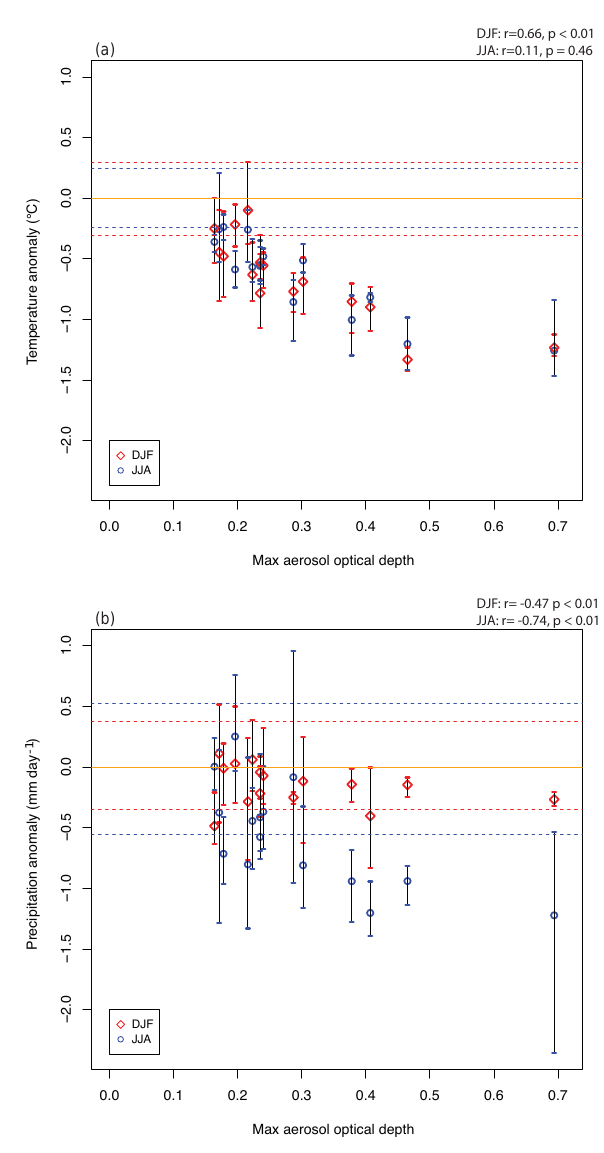
Figure 9. (a) Average temperature anomaly during DJF within the SAMS region (red; 20 to 0 ◦ S, 77.5 to 45 ◦ W) and equatorial South America during JJA (blue; 0 to 10 ◦ N, 77.5 to 52.5 ◦ W) plotted against the peak AOD for all 15 eruptions (each point averaged over three ensemble members with the three-member spread shown as horizontal bars). (b) As in (a) , but for precipitation. Dashed hor- izontal lines indicate the 5–95% range for a two-season average of each variable relative to the previous 15 years (averaged over the same domain) in the entire control simulation with no external forcing. In both panels, the correlation coefficient and p value are reported for (a) temperature and (b) precipitation vs. (cid:49)δ 18 O p in each season and over the same domain. The regression uses all 45 volcanic